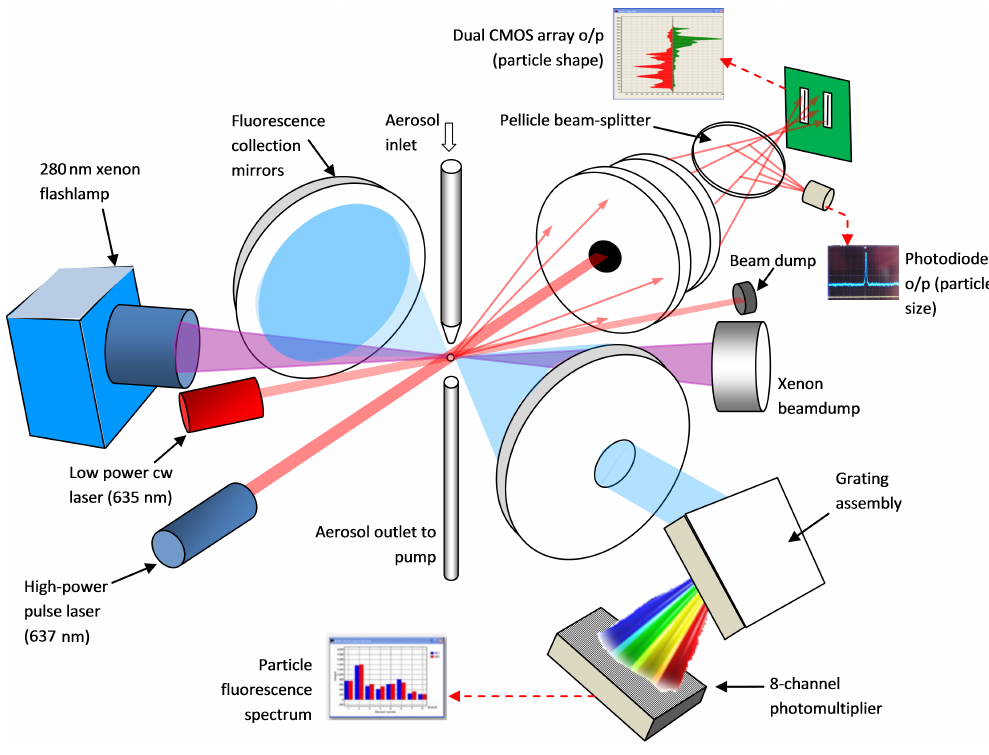
Figure 3. Schematic diagram of the Multiparameter Bioaerosol Spectrometer.